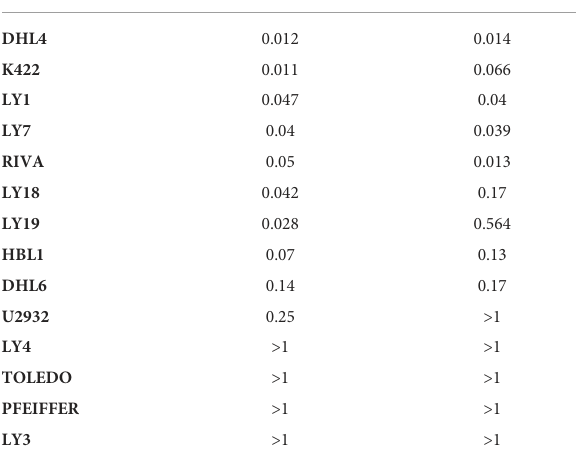
TABLE 1 AD-O51.4 and TRAIL half maximal inhibitory concentrations (IC 50 ) in DLBCL cell